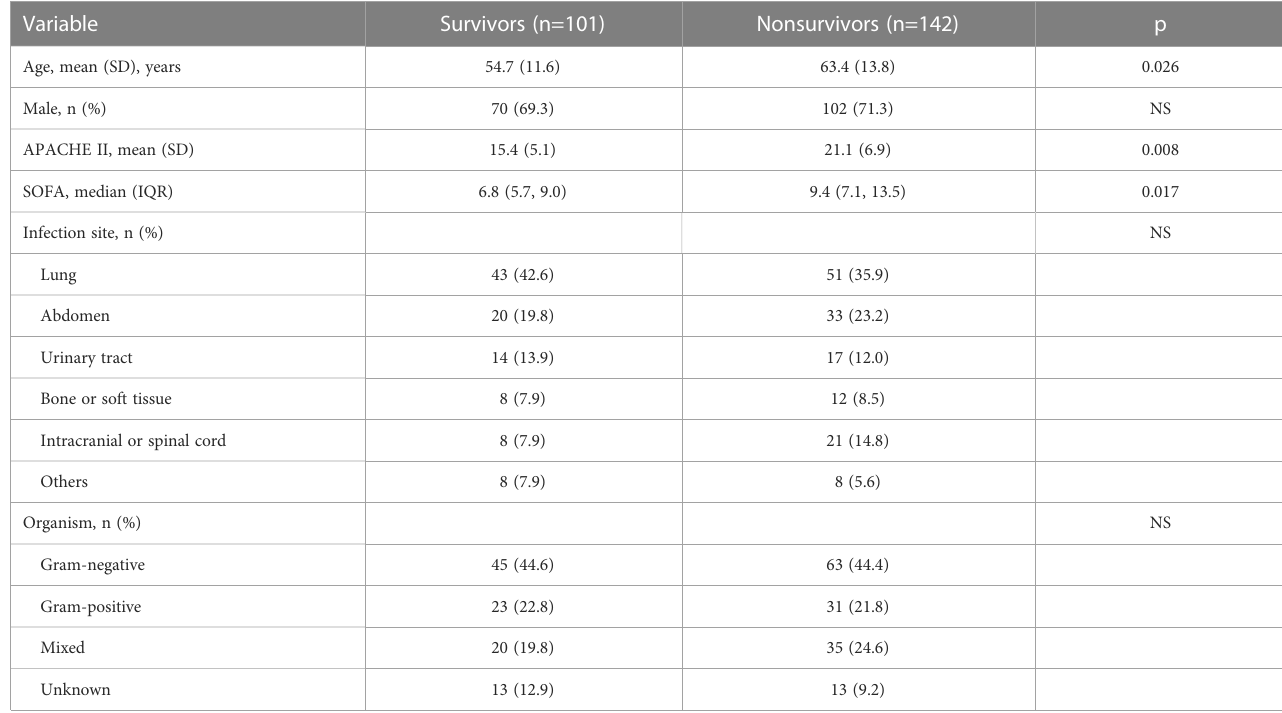
TABLE 1 Demographic and clinical data of patients with septic